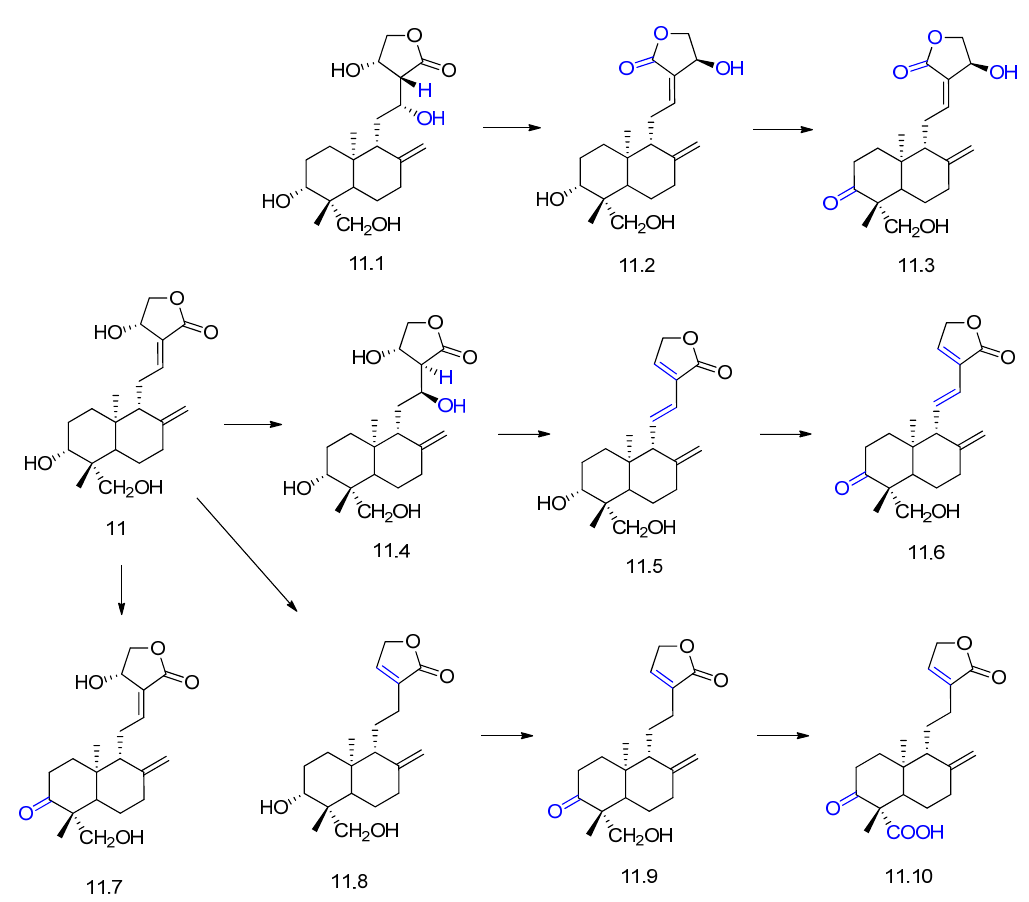
Figure 12. Andrographolide ( 11 ) and its derivatives 11.1 – 11.10 obtained by Rhizopus stolonifer biotransformation [57].